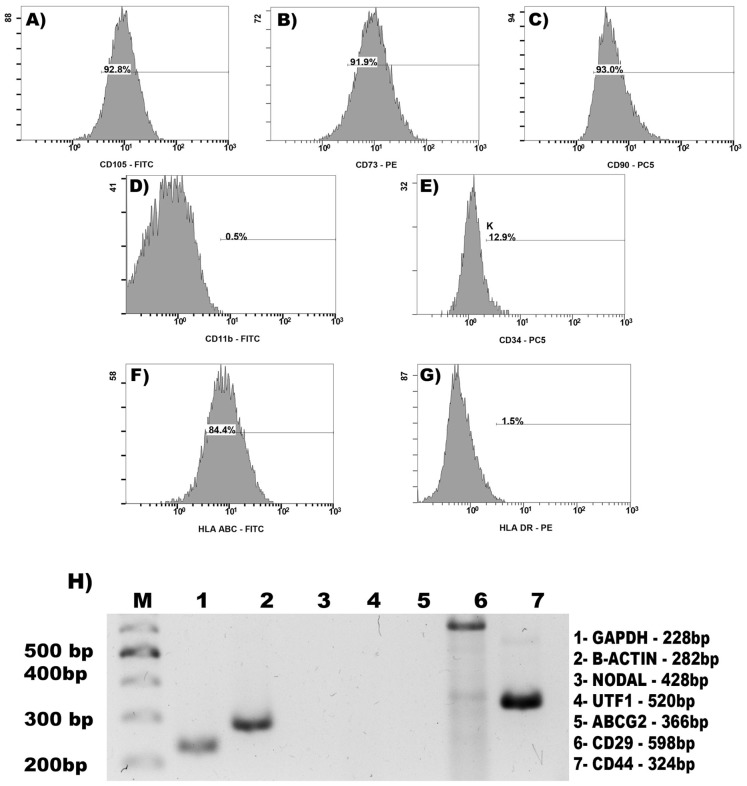
Expression of ADSC surface markers in cancer patient cells.Representative flow fluorescence activated cell sorting (FACS) and RT-PCR analysis of in vitro expanded ADSCs from cancer patients at passage 4. Cells were positive for CD105 (A), CD73 (B), CD90 (C), CD29 (H-6), CD44 (H-7) and HLA ABC (F) but do not express CD11b (D), NODAL (H-3), UTF1 (H-4), ABCG2 (H-5), or HLA DR (G); while CD34 was partially positive (E), as previously described. Lanes H-1 and H-2 show RT-PCR amplification of the house keeping genes GAPDH and β-actin, respectively.